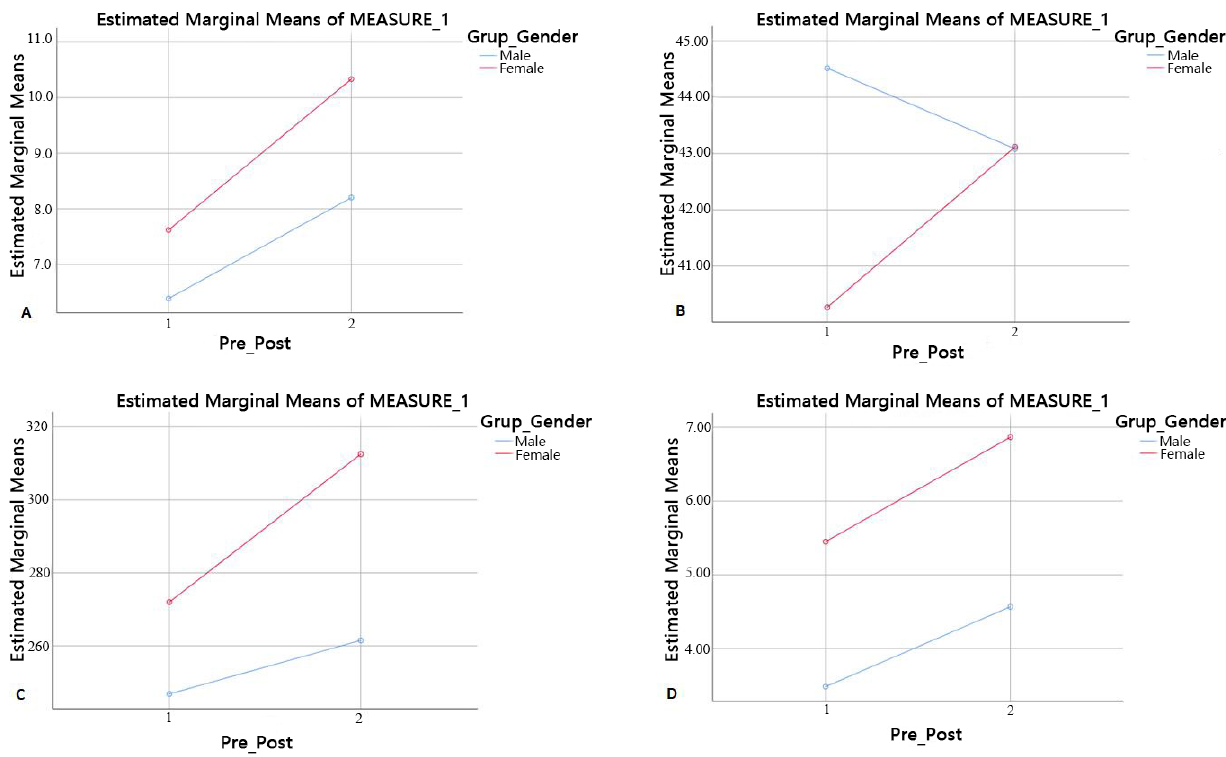
Fig. 1. The interaction effect of gender on hematological parameter changes . (A) WBC (10 3 / µ L). (B) Hct (%). (C) PLT (10 3 / µ L). (D) GRAN (10 3 / µ L), * p <